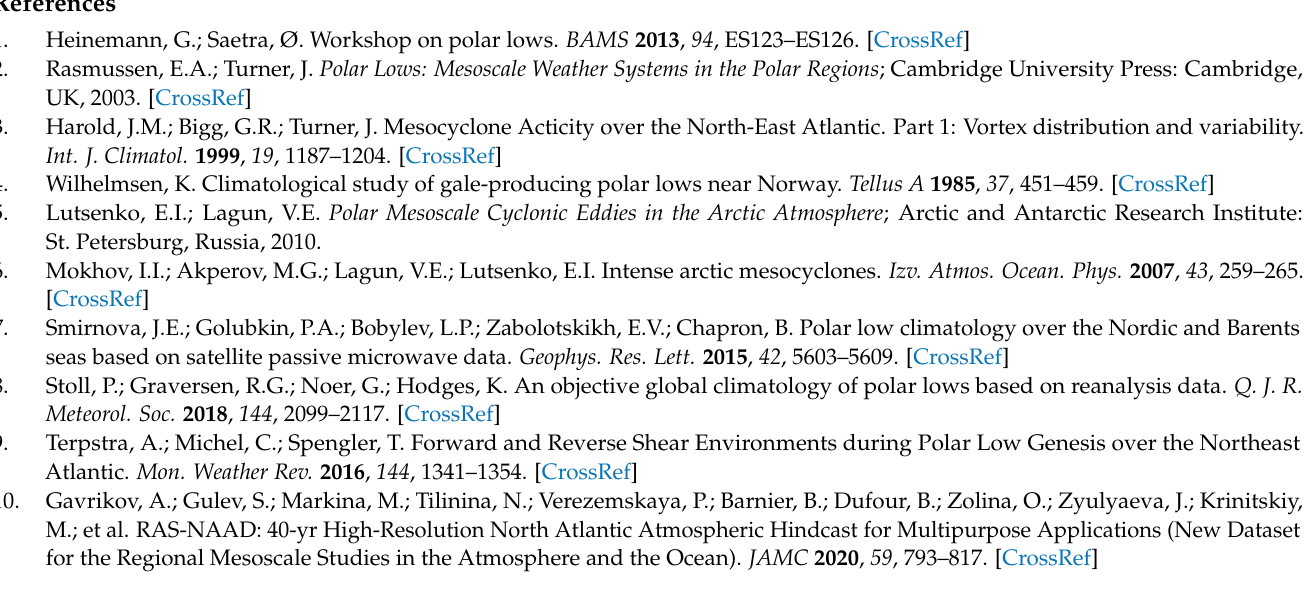
Figure A6. ICON-A6.5: air temperature at 500 hPa ( a ) and vertical temperature profile along 73 ◦ N in the layer 1000-200 hPa ( b ) at 05:00 UTC 26.02.2020. Preliminary location of polar low is shown by dotted lines.